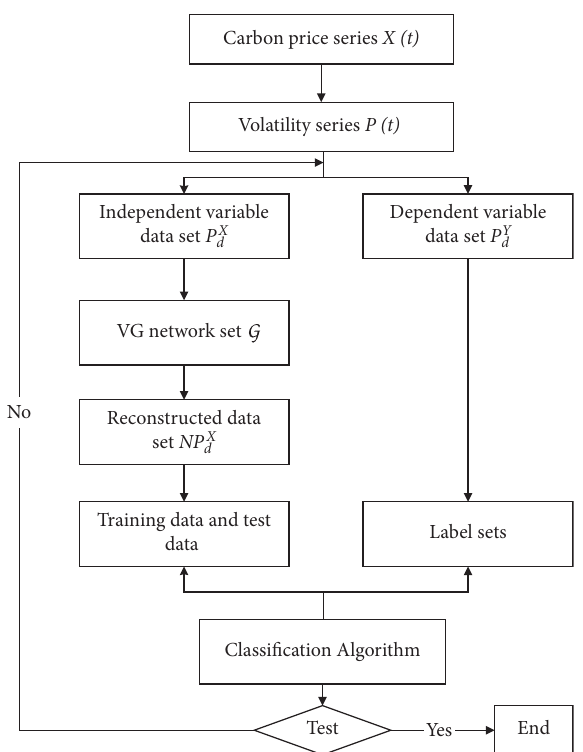
Figure 1: Flowchart of the prediction algorithm with network topology information